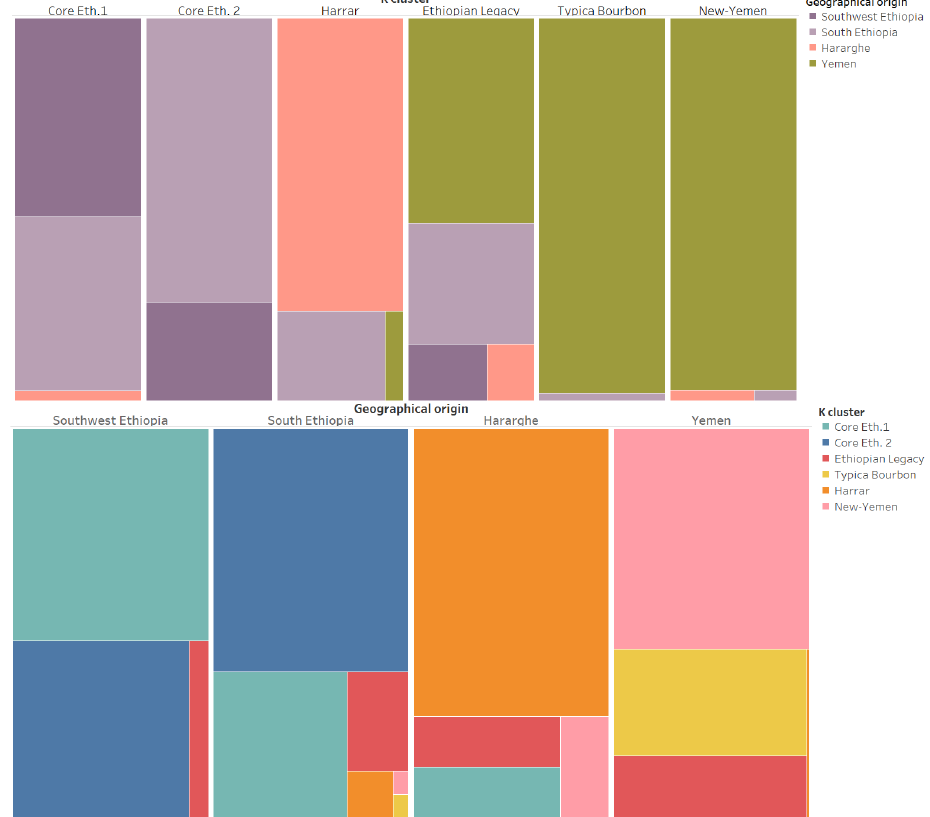
Figure 5. Schematic relationship between genetic clusters and geographical origins of C. arabica samples in the study. For each geographical origin ( up ), the colored area is proportional to the% of each cluster in the given geographical origin. The sum of % in each geographical origin is equal to 100. For each K cluster ( bottom ), the colored area is proportional to the corresponding % of geographical origin. The sum of % in each cluster is equal to 100.